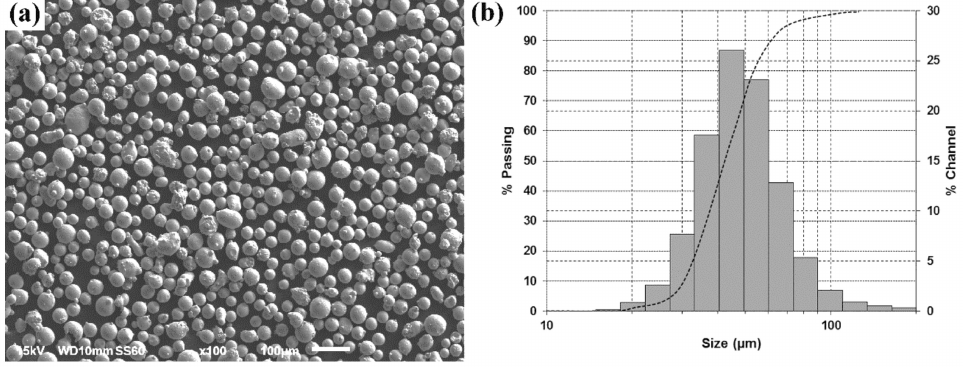
Figure 1. Scanning electron micrograph ( a ) and particle size distribution ( b ) of the 17-4PH SS powder.